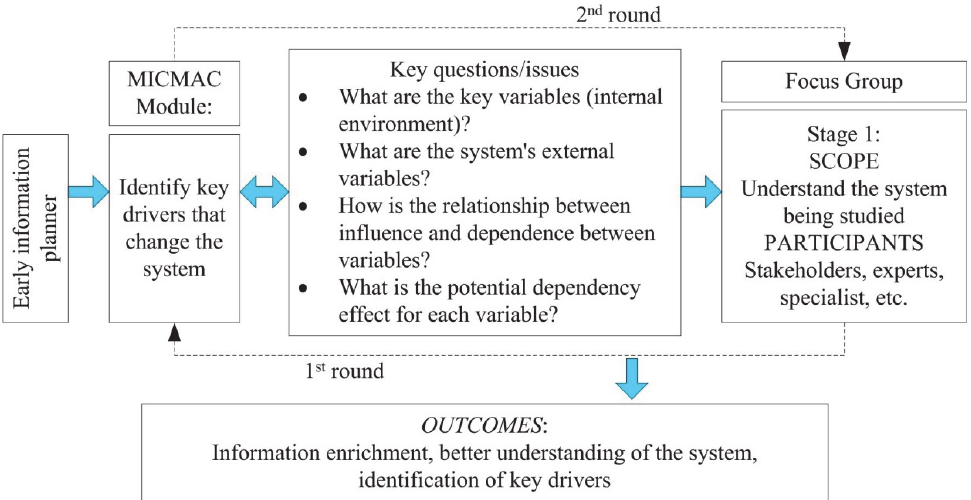
Fig. 2. MICMAC Framework (Stratigea in Fauzi,